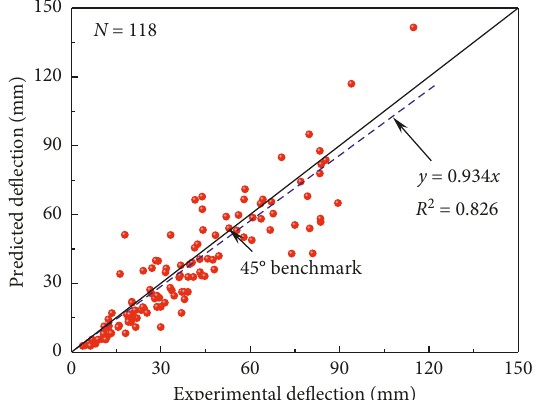
Figure 16: Comparison of experimental and predicted maximum deflection with the existing method